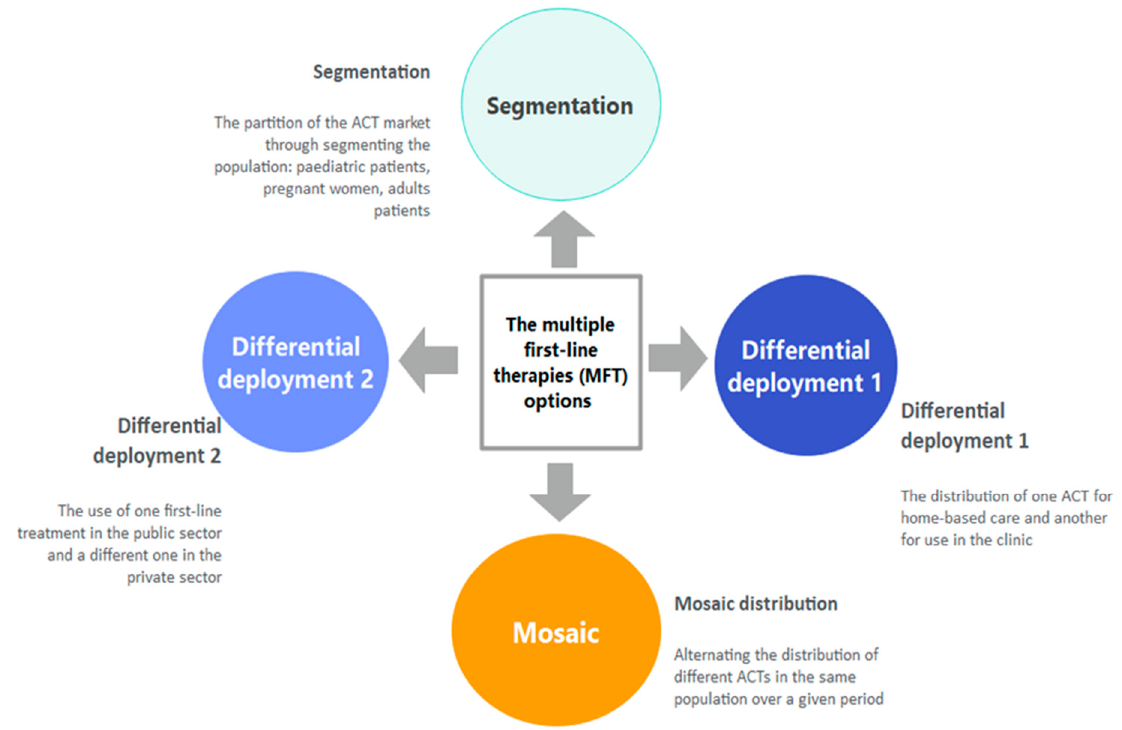
Figure 1. Possible options for deploying the MFT